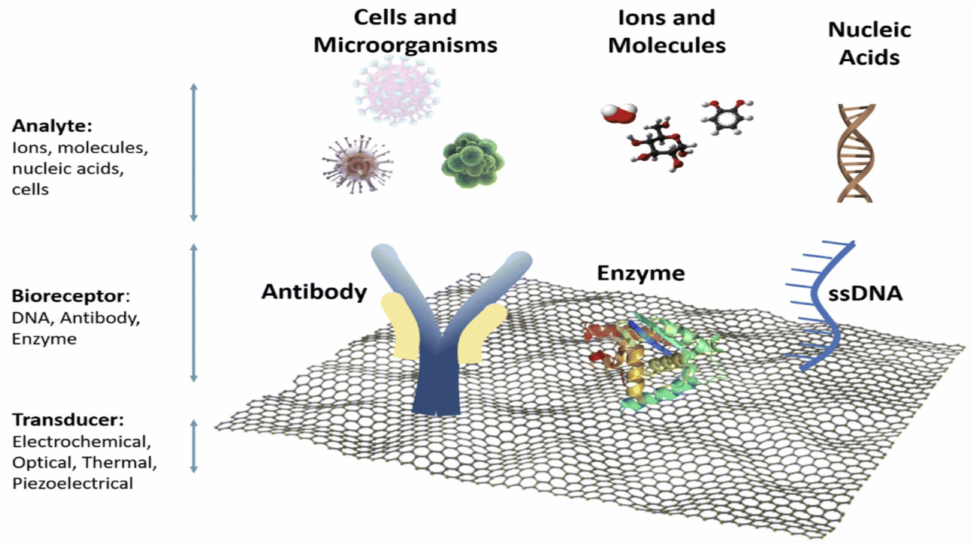
Figure 16. Structure of antibody biosensor. Reprinted by permission from